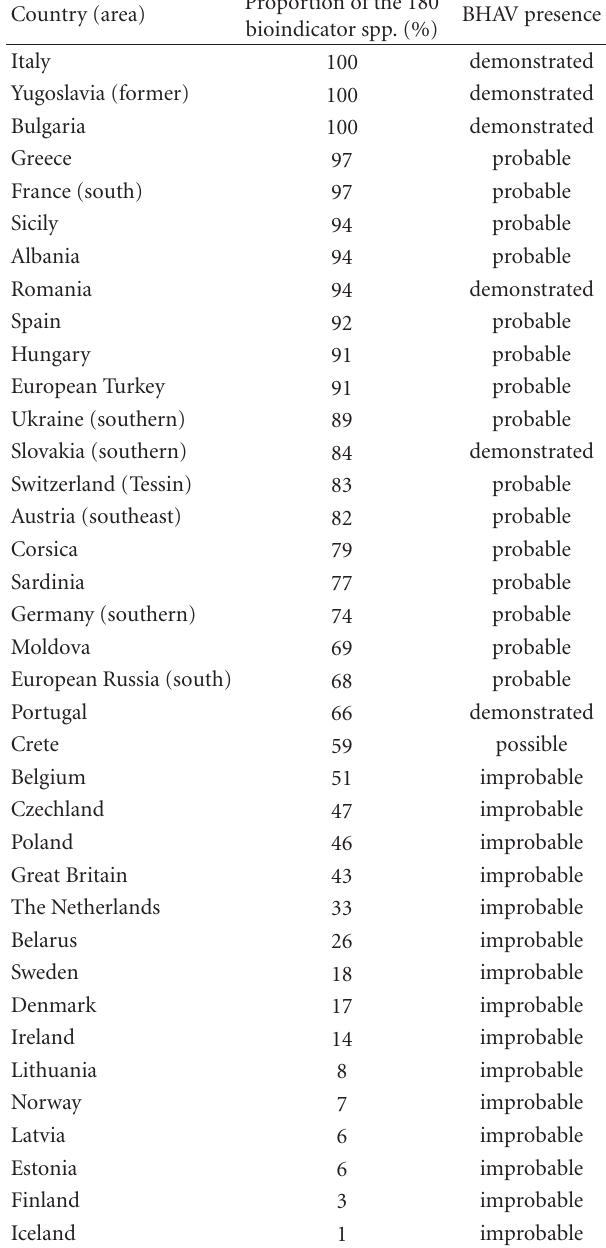
Table 3: Bhanja virus—prediction of occurrence in European